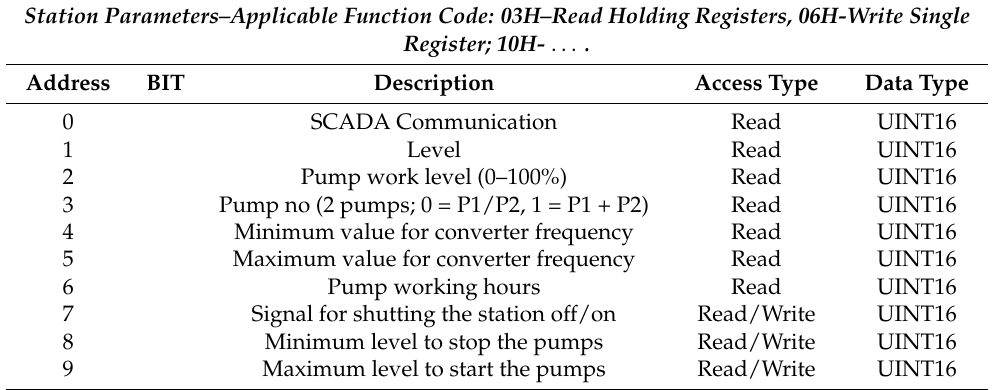
Table 1. Data tag standardization. (An example for a pumping station). Data Tag